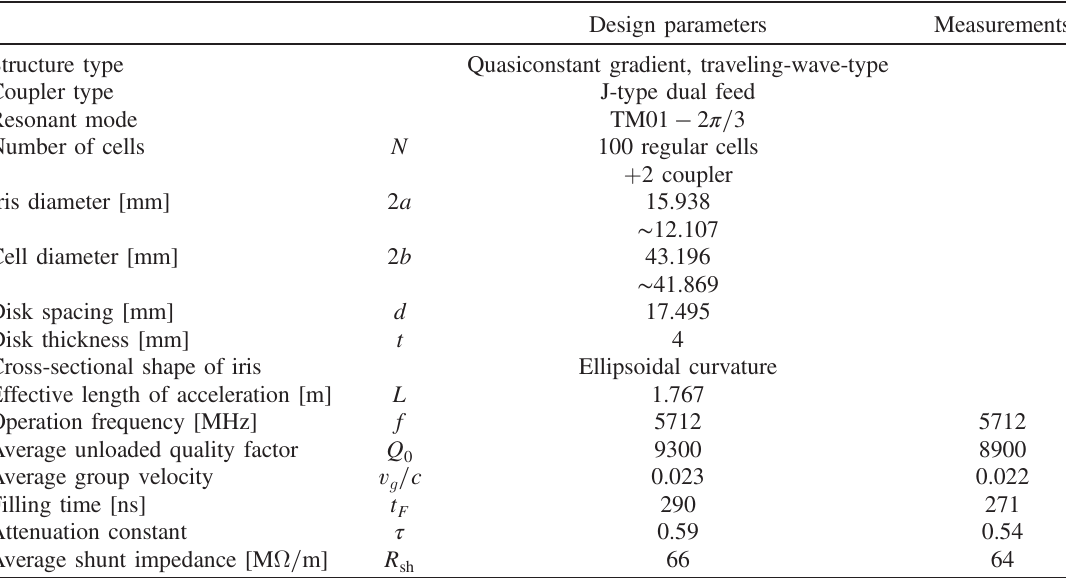
1. (a) Cross-sectional view of the C -band disk-loaded-type accelerating structure. (b) Outer view of the new C -band accelerating shows a cross-sectional view of the ellipsoidal iris shape and =E the ratio ( E ) of the maximum surface electric field, p acc E , to the average acceleration field, E , as a function of the p acc ratio of B=A . The solid line with solid circle dots and the TABLE I. Design parameters and measured values of the C -band disk-loaded-type accelerating structure.